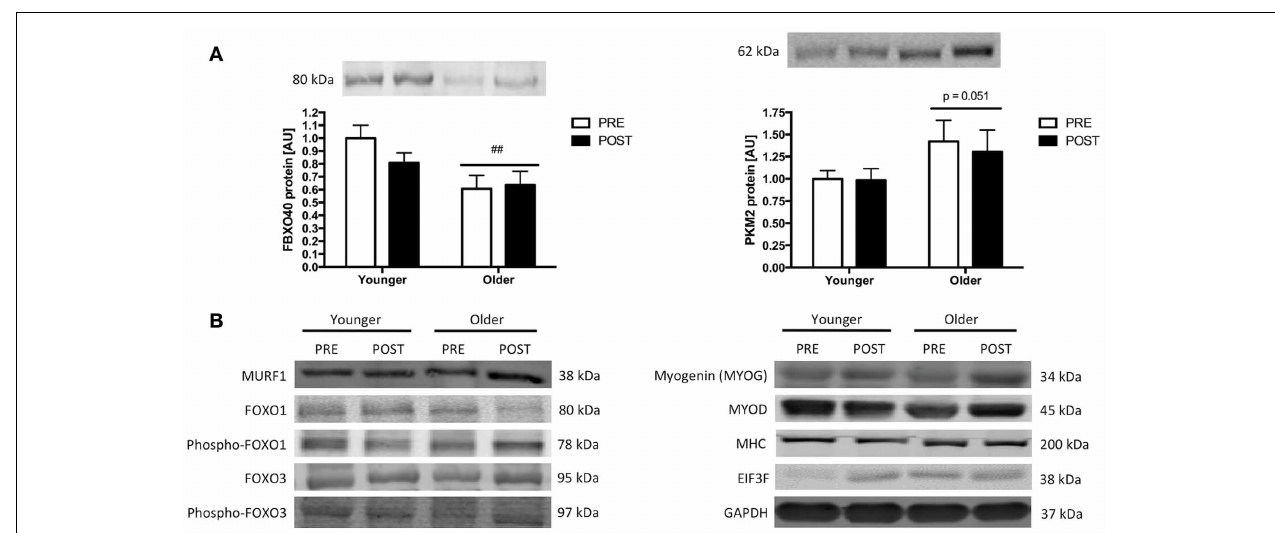
FIGURE 2 | (A) FBXO40 and PKM2 protein expression following a single-bout of resistance exercise in younger and older people. Note that no changes were observed for the other proteins measured. ##significantly different from Young, p < 0 . 01. The reported statistical significance is based on analysis of the transformed data but the reported means ±